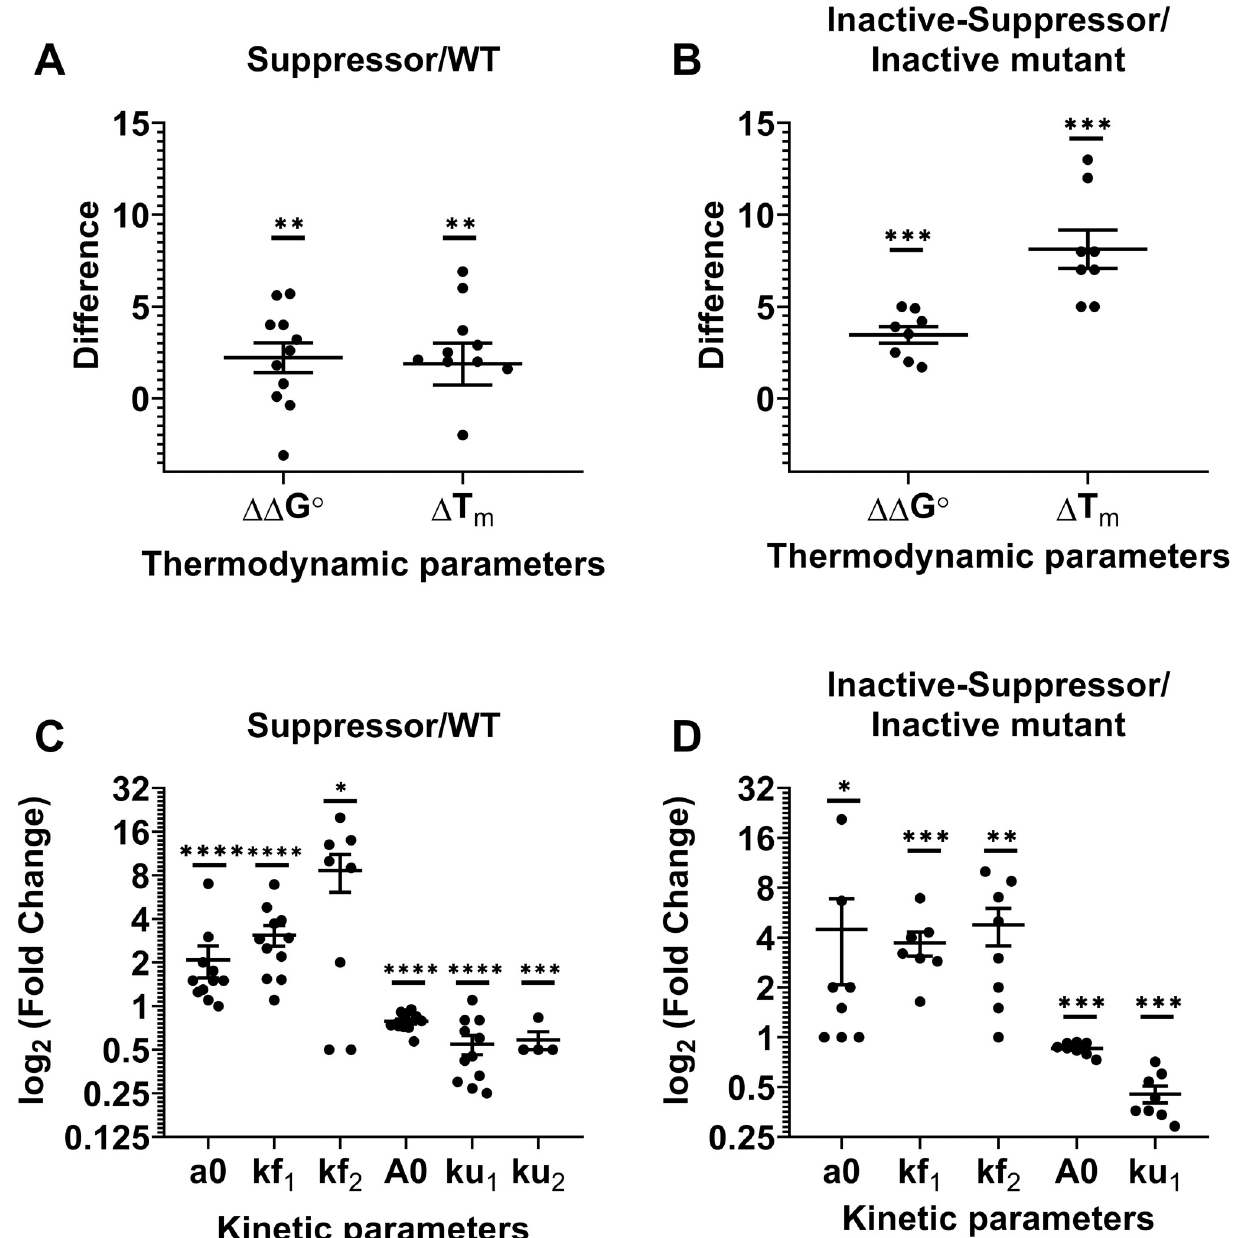
Fig 8. Suppressor mutations have larger effects on refolding kinetics than on unfolding kinetics or protein stability parameters. (A-B) Distribution of Δ T m (˚C) and ΔΔ G˚ (kcal/mol) (Mean ± SEM) for the suppressor mutations in the background of WT (A) or inactive mutants (B). Mann Whitney non- parametric test was performed for each of these parameters to examine if they are significantly different from zero. (C-D) Log 2 fold change of various kinetic parameters (Mean ± SEM) for the suppressor mutations in the background of WT (C) or inactive mutant (D). Mann Whitney non-parametric test was performed for each of these parameters. The mean of the distributions of the values for each of the parameters are significantly higher than log 2 (2) for refolding, and lower than log 2 (2) for unfolding. � , �� and ��� indicate values of P < 0.05, < 0.005 and < 0.0005 respectively. ΔΔ G˚ and Δ T m represent the difference in Gibbs free energy and apparent melting temperature T m for suppressor containing protein relative to the corresponding values for either WT (A) or Parent Inactive Mutant (B). a0, kf 1 , kf 2 , A0, ku 1 , ku 2 are the burst phase amplitude for refolding, rate constant of fast phase of refolding, rate constant of slow phase of refolding, amplitude of burst phase of unfolding, rate constant of fast phase of unfolding, and the rate constant of slow phase of unfolding